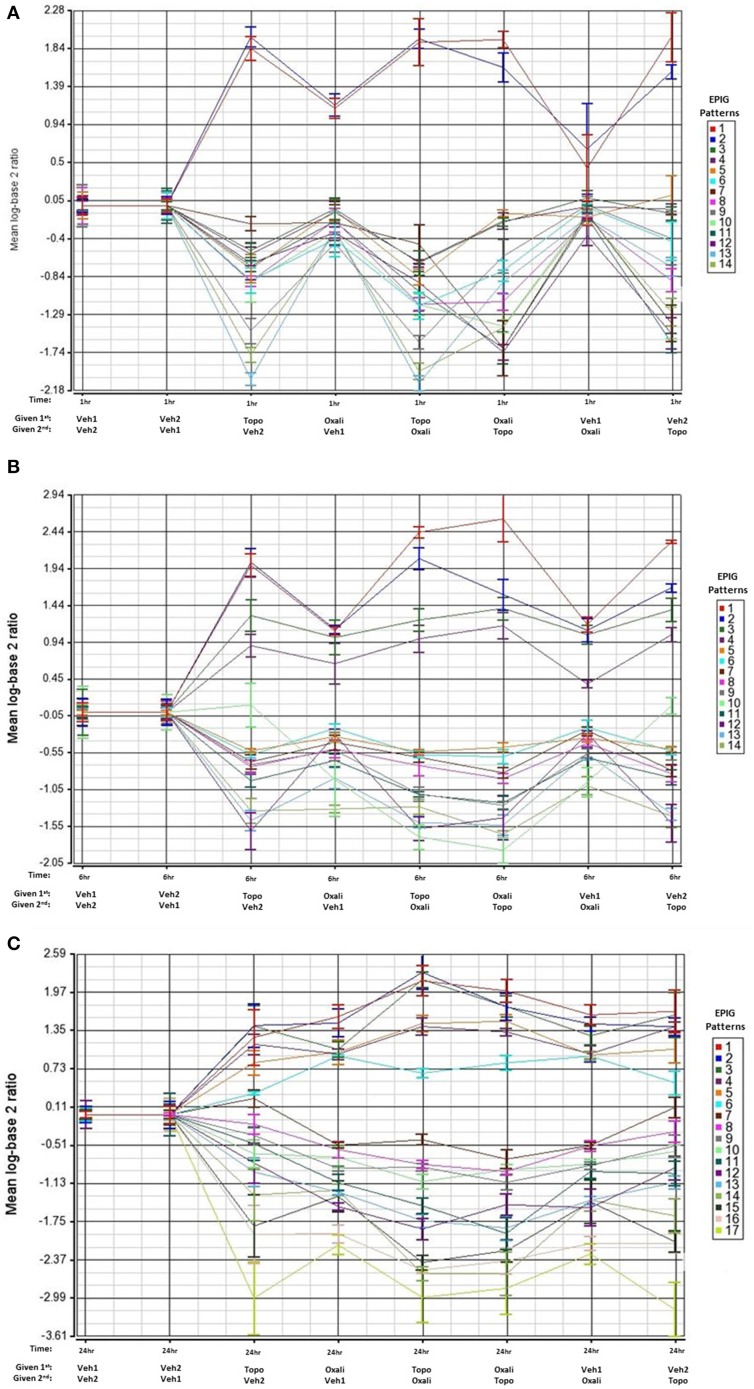
EPIG patterns across treatments groups 1, 6, and 24 h post-treatment. The average of the log base 2 ratio (treated sample to the average of the time-matched control) from the top 6 expression profiles with the highest degree of correlation are plotted and displayed on the y-axis. The x-axis contains the treatments and the order of exposure. Oxali = oxaliplatin (15 mg/kg) and Topo = topotecan (4.7 mg/kg). (A) Patterns extracted by EPIG of mRNA from bone marrow samples that were collected 1 h post-treatment administration. The row labeled 1st denotes which agent was administered first. (B) Same as A except analysis of mRNA from bone marrow samples that were collected 6 h post-treatment. (C) Same as A except analysis of mRNA from bone marrow samples collected 24 h post-treatment.